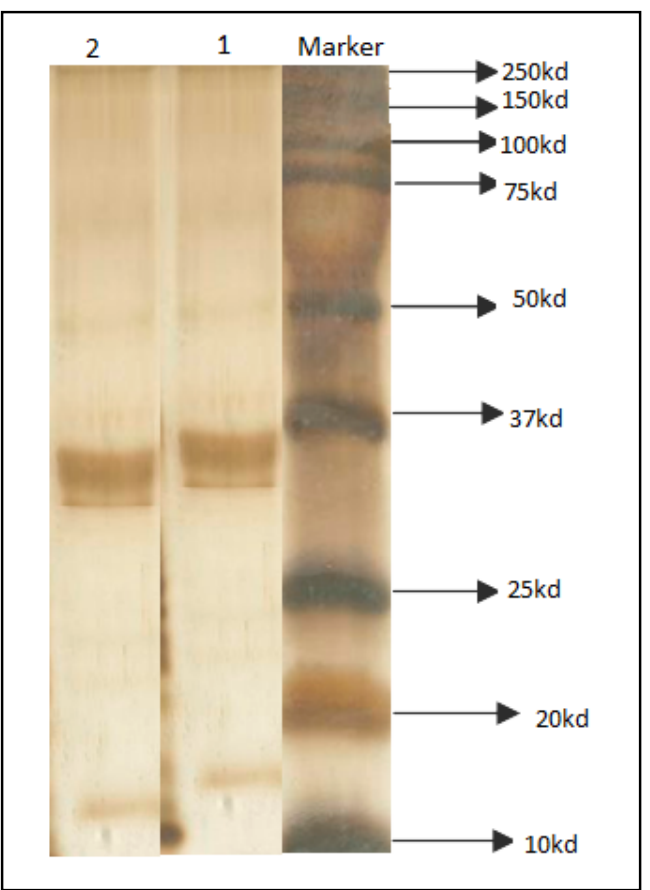
Figure 4. SDS − PAGE, zymogram of purified Lipase produced by Bacillus halotolerans . VSH 09.